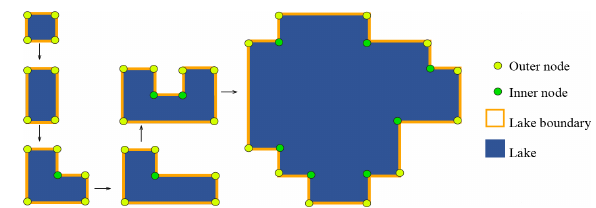
Figure A3. Sketch of outer and inner nodes of various glacial lakes without island.